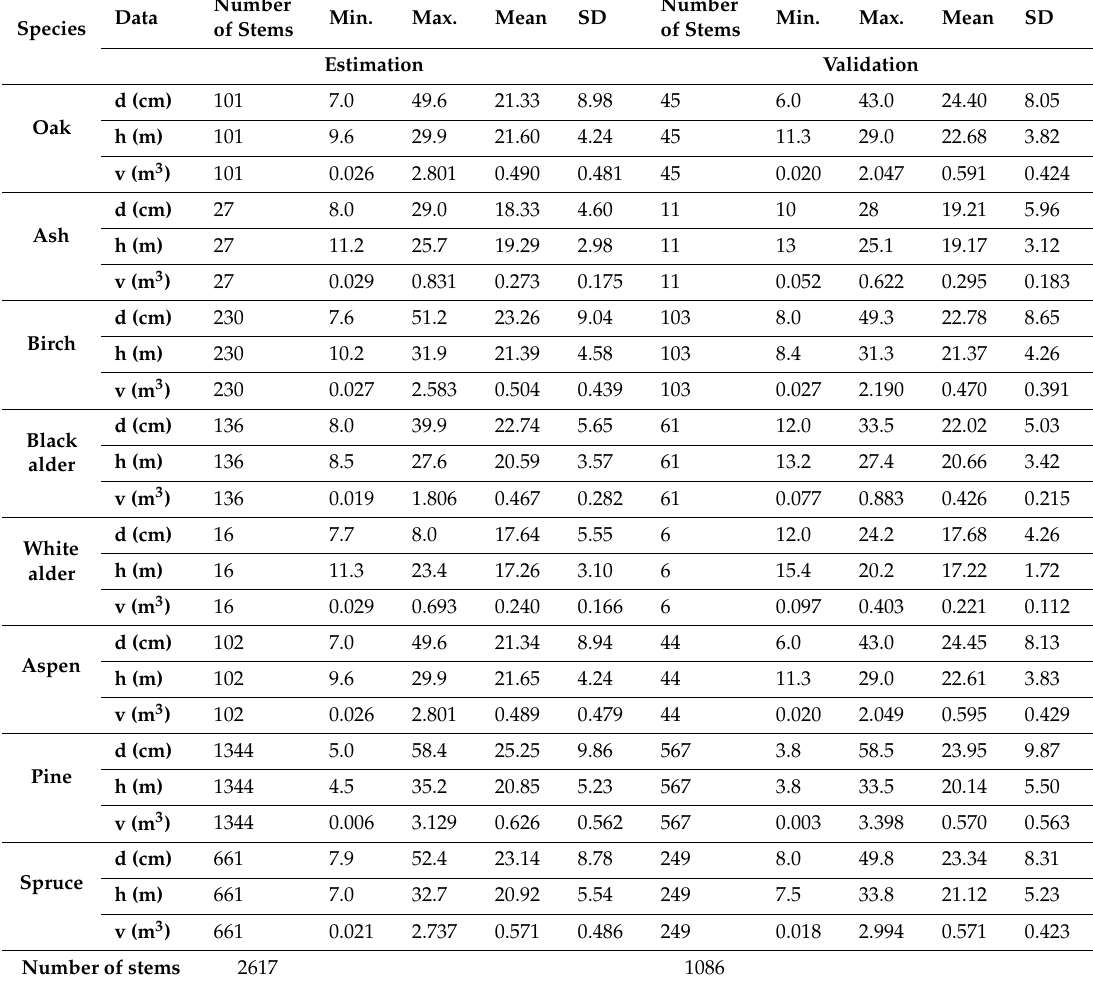
Table 1. Summary statistics of all measured stems. SD: standard